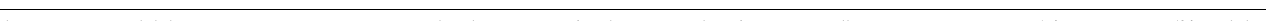
Fig. 3 UNC119-solubilising activity maintains SFK PM localisation. Confocal micrographs of MCF10a cells expressing Src-mCit ( a ) or Fyn-mCit ( b ) and the ER marker, CalR-mCer transfected with UNC119 targeting siRNA ( lower rows ) or non-targeting siRNA control nucleotides ( upper rows ). c Representative western blot showing UNC119 levels of transfected cells and the GAPDH-loading control. Bar graph depicts the quanti fi cation of UNC119 kD in which UNC119 levels were normalised to the tubulin-loading control and the non-targeting siRNA control ( n = 4, data are mean ± SD; signi fi cance determined by Student ’ s t -test). d Quanti fi cation of co-localisation with Mander ’ s coef fi cient for SFK-mCit with the ER CalR-mCer marker in MCF10a cells ( n > 30 cells per condition from two independent experiments; data are mean ± SD. * P < 0.05; *** P < 0.001; Student ’ s t -test). Confocal micrographs of HeLa cells expressing Src-mCit e or Fyn-mCit f and the ER marker; CalR-mCer e or stained with anti-Calnexin antibodies f , transfected with UNC119 targeting siRNA ( lower rows ) or non-targeting siRNA control nucleotides ( upper rows ). g Quanti fi cation of co-localisation with Mander ’ s coef fi cient for SFK-mCit with the ER markers for HeLa cells ( n > 15 cells per condition from two independent experiments; data are mean ± SD. * P < 0.05; *** P < 0.001; Student ’ s t -test). h Quanti fi cation of UNC119 KD in HeLa cells by western blot using UNC119 and tubulin antibodies. UNC119 levels were normalised to the tubulin-loading control and the non-targeting siRNA control ( n = 5, data are mean ± SD; ** P < 0.001; Student ’ s t -test). i Confocal micrographs of MCF10a cells transfected with UNC119A and UNC119B targeting siRNA or non-targeting siRNA control nucleotides and then stained with an antibody against SFKs ( green ) and with DAPI ( blue ). Traces below show the vertical intensity pro fi le plots of SFK for the yellow dashed area . j The mean SFK intensity pro fi le plots for multiple cells ( n = 20 cells per condition, mean intensity ± SEM). Scale bars , 10 μ